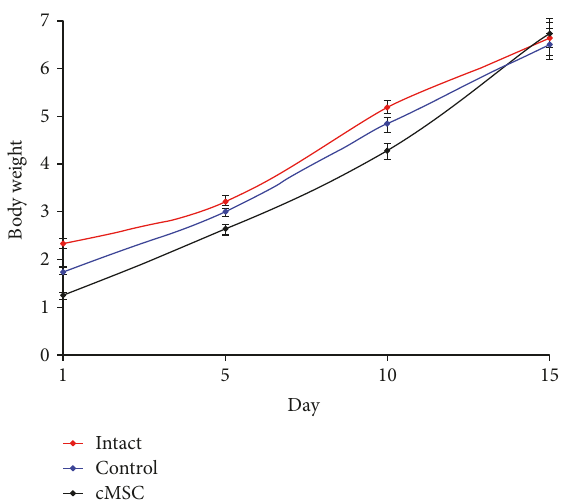
Figure 7: Dynamicsofbodyweightoflitters. Therewasaslowriseof bodyweightinthecontrolgrouprelativetoonesfromothergroupsat early observation terms, and to the 15th day, this di ff erence leveled. ∗ Statistically signi fi cant di ff erence with corresponding index in the intact group ( p < 0 05